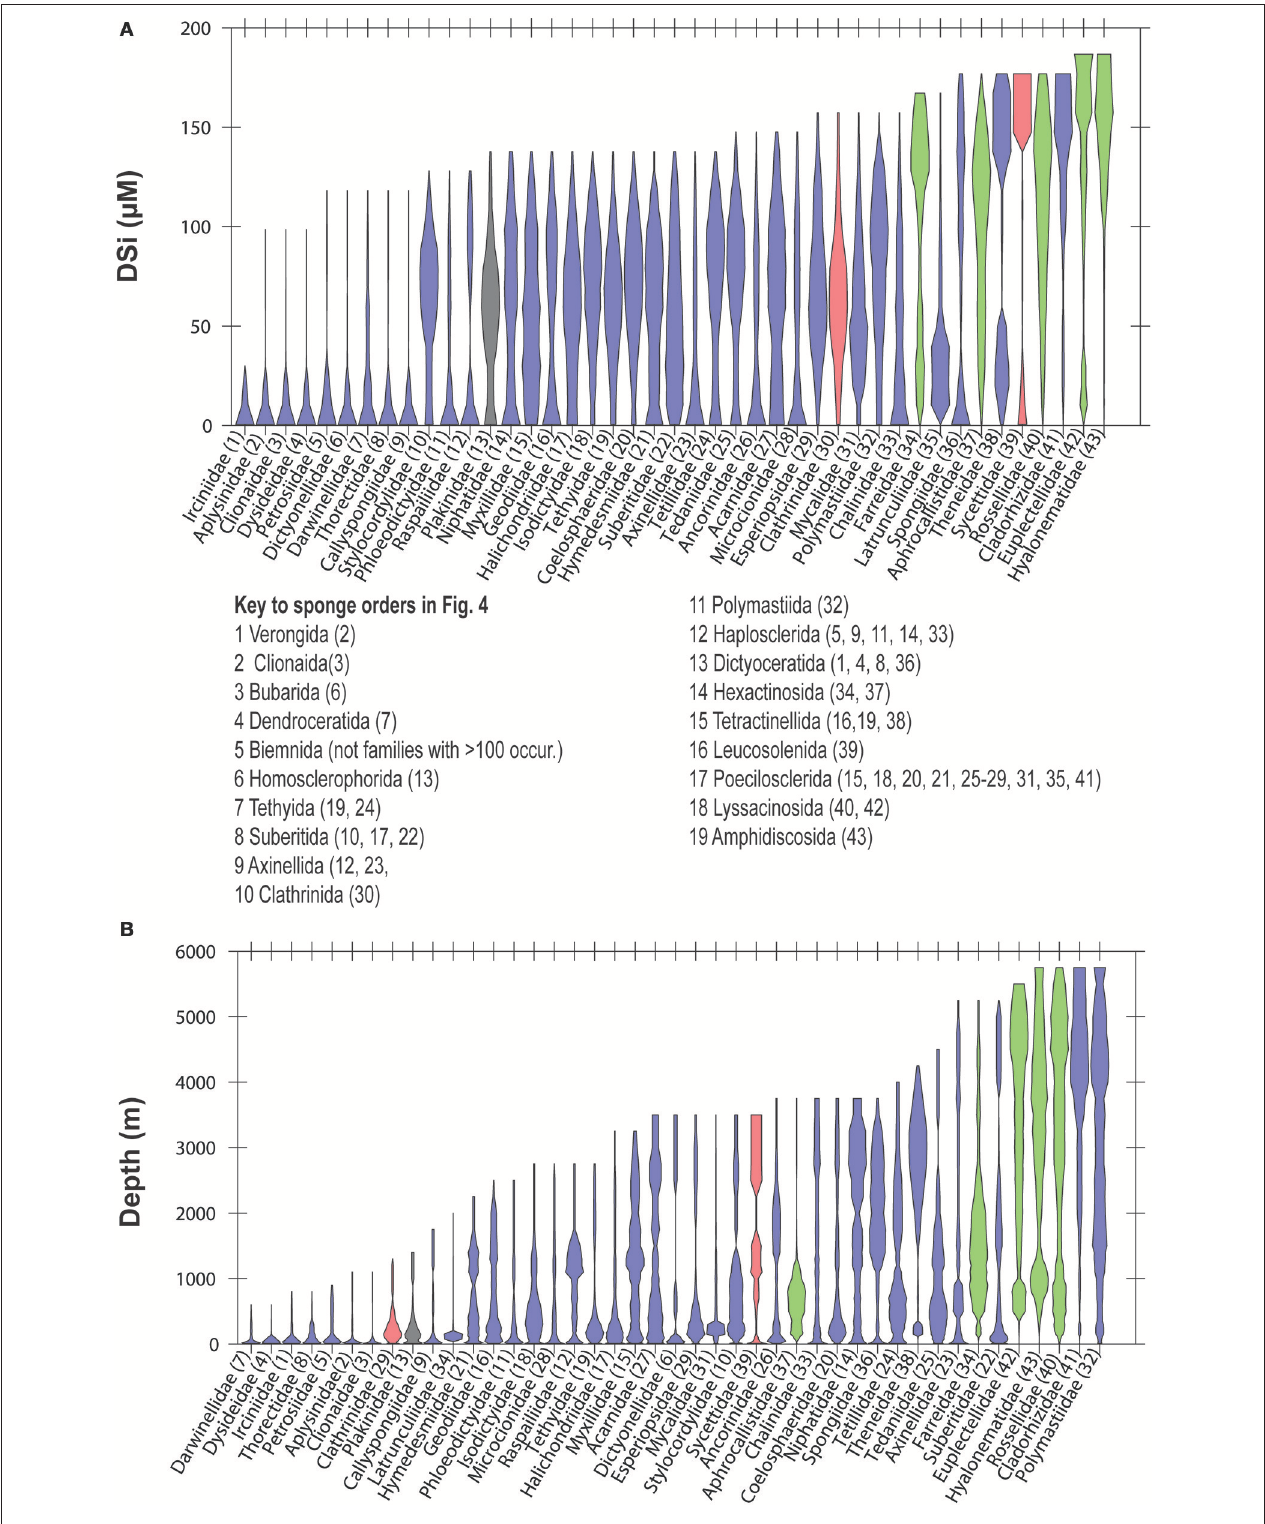
FIGURE 5 | Violin plots showing the distribution of sponge families in a dSi gradient (A) and a depth gradient (B) . Only families represented within GBIF in at least 100 boxes of WOCE dataset are shown. Numbers in parenthesis are codes given to each family. Taxa with gray background include sponges without siliceous spicules. A key to the orders represented in Figure 4 is included. Color codes as in Figure